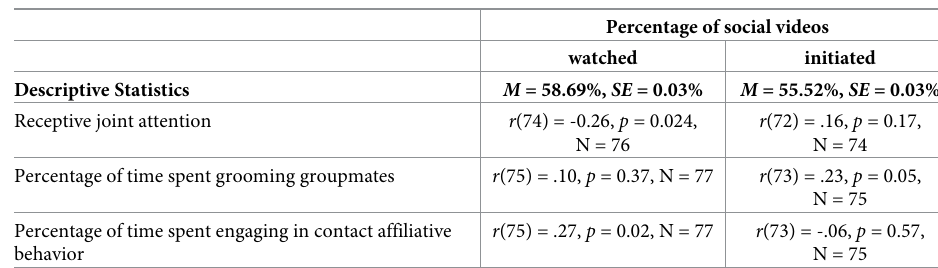
Percentage of social videos watched initiated r (72) = .16, p = 0.17, N = 76 N = 74 N = 75 r (75) = .27, p = 0.02, N = 77 r (73) = -.06, p = 0.57, N = 75